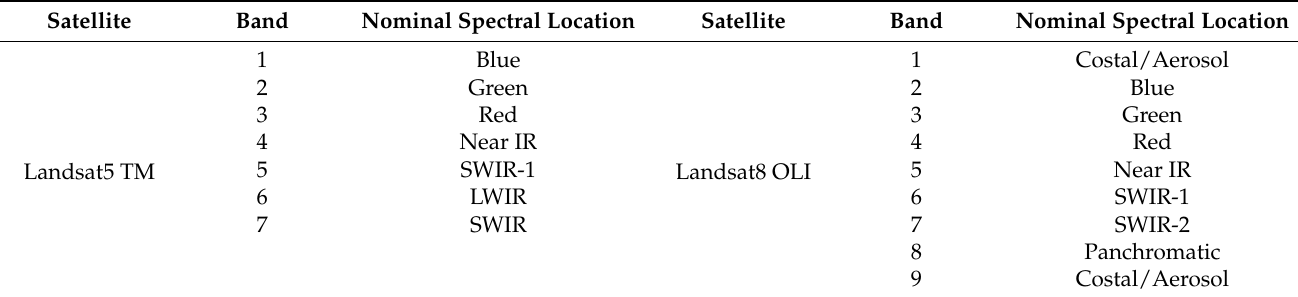
Table 1. Landsat 5 TM/8 OLI data